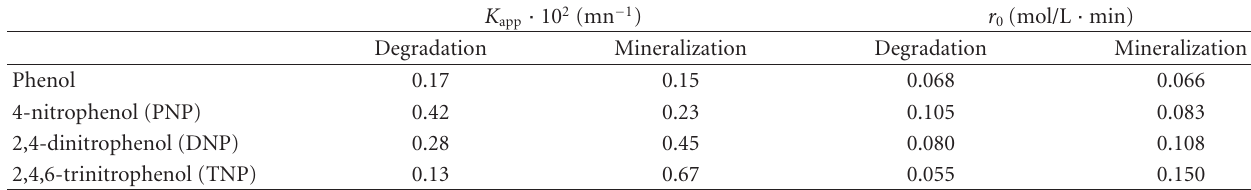
Table 5: Solar degradation and mineralization kinetics ( K app , r 0 ) of phenolic